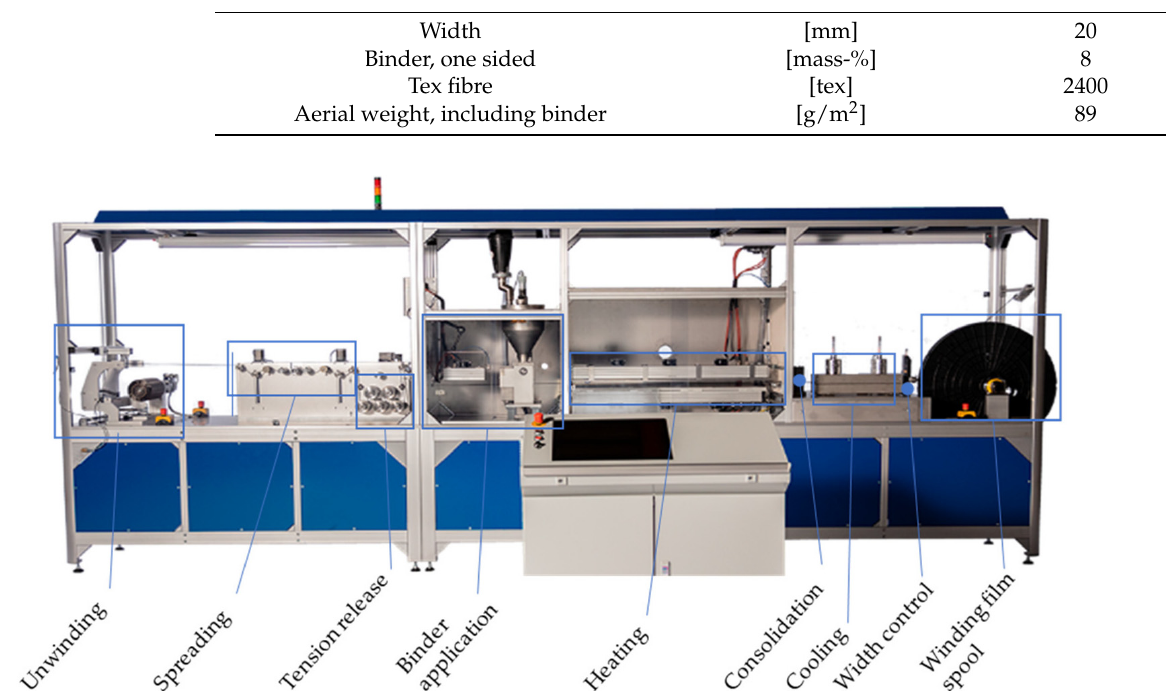
Figure 3. Spreading machine from M&A Dieterle GmbH to produce the fixed tow